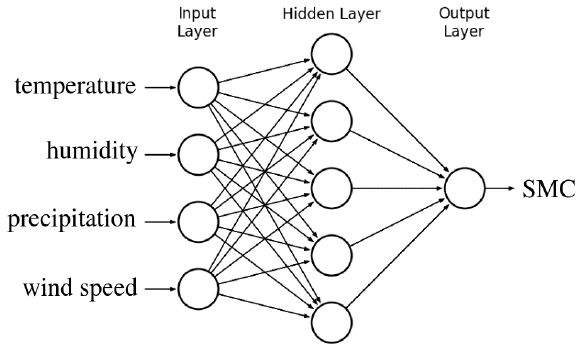
Figure 7. Neural network to predict SMC